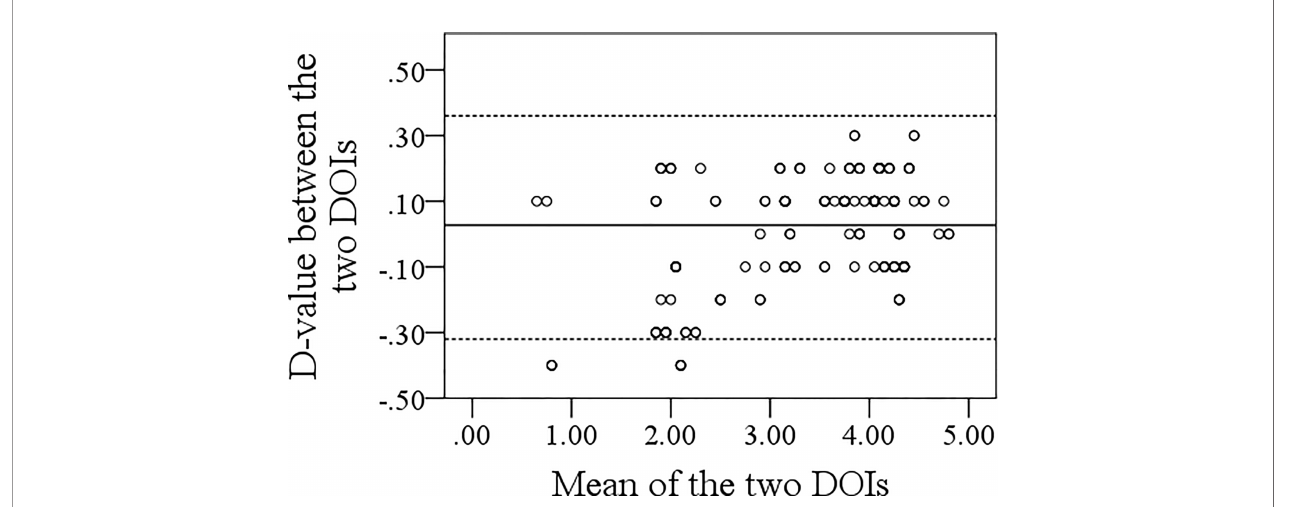
FIGURE 3 | Bland – Altman analysis of the association between sonographic and pathologic depth of